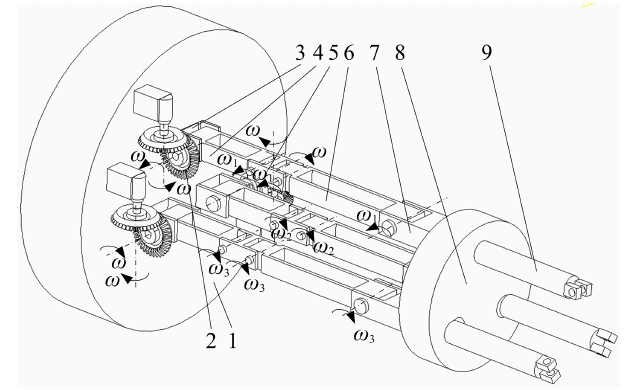
Figure 2. Big arm structure diagram of winding robot. (1) Base, (2) bevel gear groups, (3—7) middle rod, (8) moving platform, (9) big arm connecting rod.